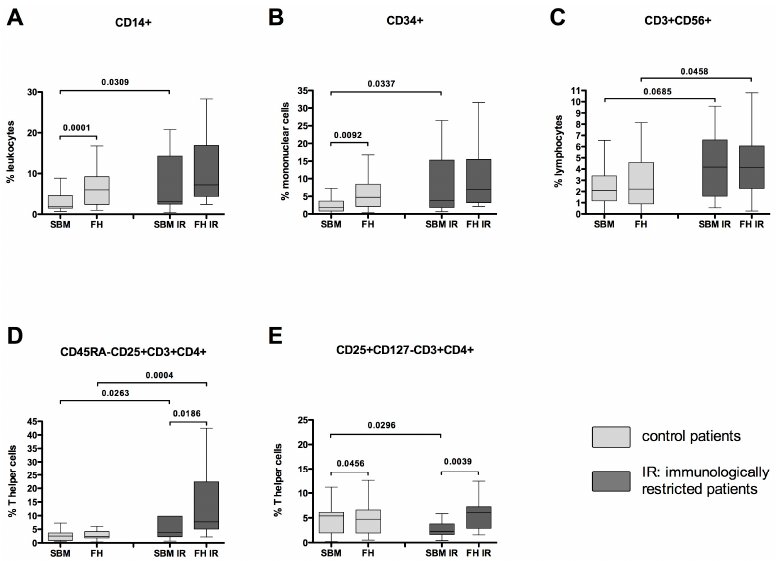
Figure 1. Monocytes/macrophages, hematopoietic stem and progenitor cells, natural killer T (NKT) cells and activated T helper cells accumulate in fracture hematoma (FH)/surrounding bone marrow (SBM) of immunologically restricted (FH IR/SBM IR) patients while regulatory T cells are decreased in SBM. Leukocytes from FH IR/SBM IR of immunologically restricted patients (dark grey) and controls (light grey) were isolated, stained with various surface markers and analyzed by flow cytometry. ( A ) Within all leukocytes, the CD14+ monocytes/macrophages were detected; ( B ) CD34+ hematopoietic stem and progenitor cells were detected within the mononuclear cells; ( C ) CD3+CD56+ NKT cells were detected within lymphocytes; ( D ) The activated CD45RA − CD25+CD3+CD4+ T helper cells were detected within the whole T helper cell population; ( E ) CD25+CD127 − CD3+CD4+ regulatory T cells were detected within the whole T helper cell population. Controls n = 42, IR patients n = 20. IR-patients vs. controls Mann-Whitney U test, FH vs. corresponding SBM Wilcoxon test, p -values < 0.05 are shown as numbers in the Figure.